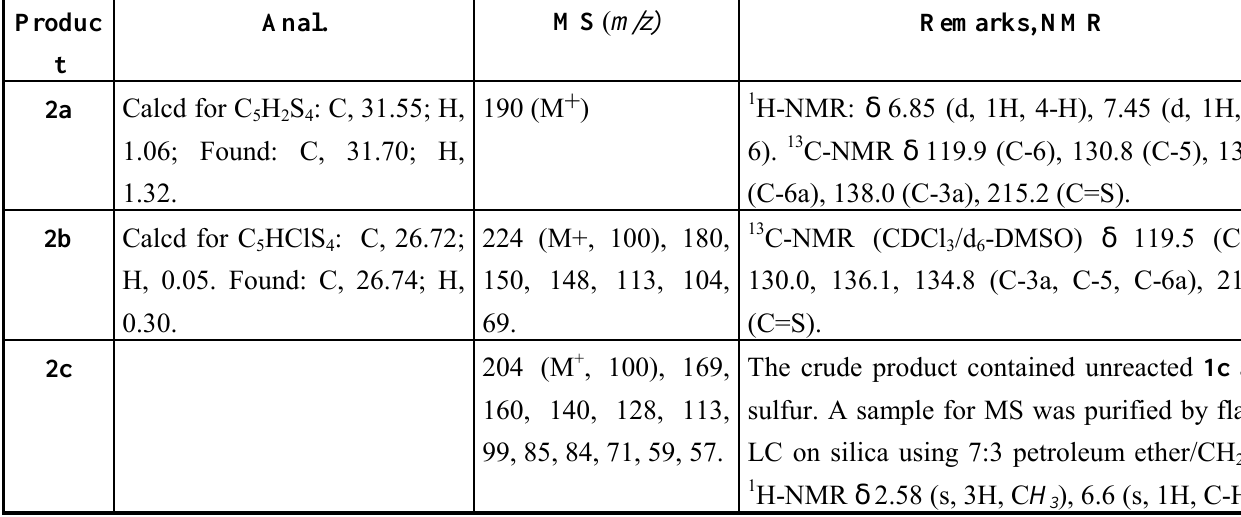
Table 2: Physical Properties of Compounds 2 and